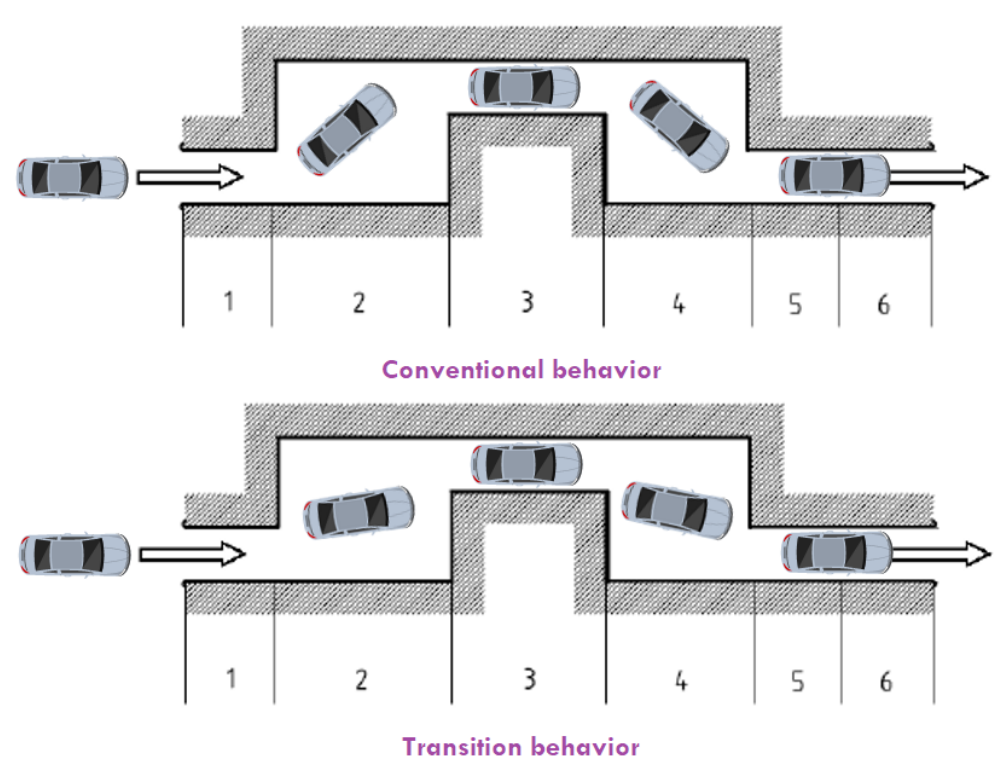
Figure 25. Illustration of the difference between motion